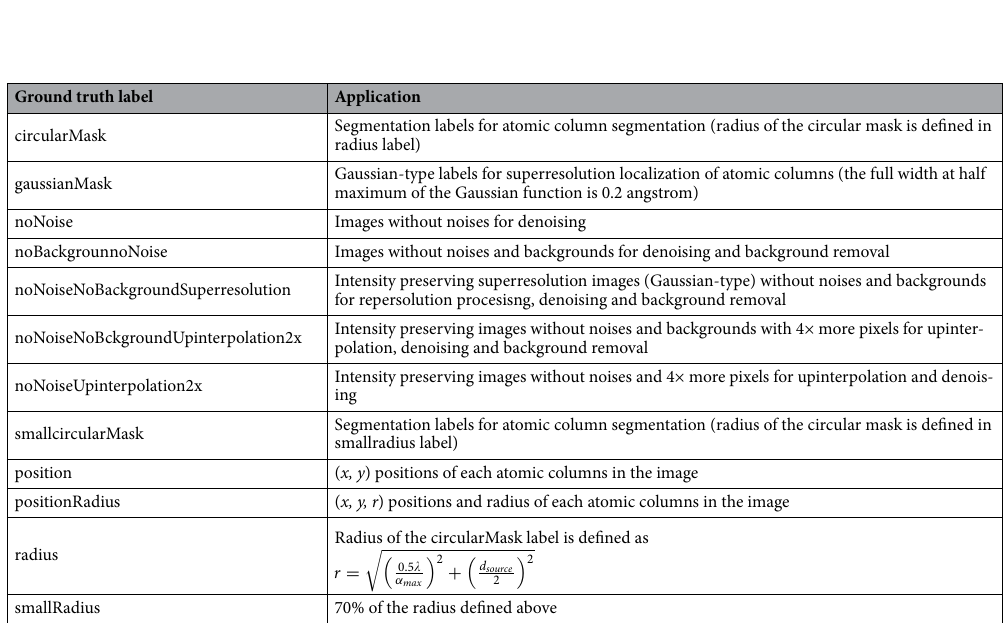
Table 2. Description of ground truth